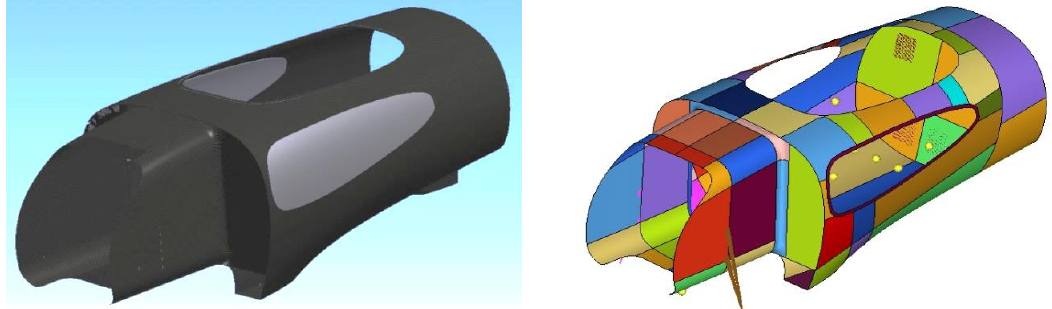
Figure 4. Central part CAD design ( left ) and subdivision to enhance mesh quality ( right ).